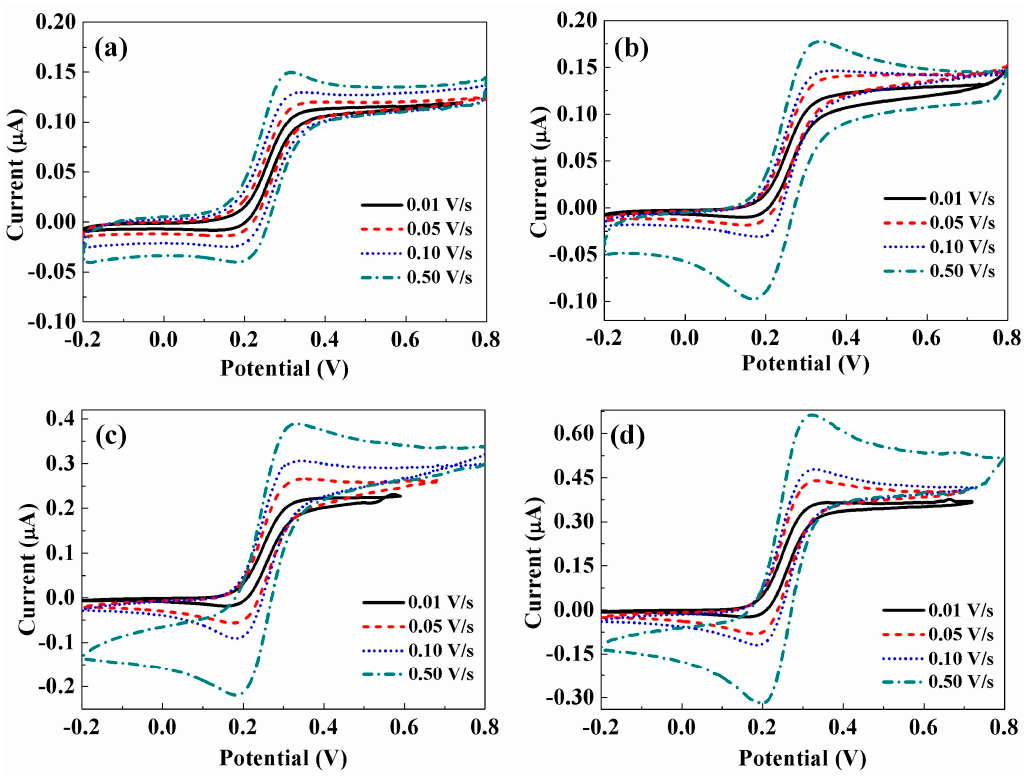
Figure 6. Cyclic voltammograms of ( a ) CFME-T0, ( b ) CNTs/CFME-T5, ( c ) CNTs/CFME-T10, ( d ) CNTs/CFME-T15 in 5.0 mM K 4 Fe(CN) 6 (in 1.0 M KCl) at a scan rate of 0.01 V·s − 1 , 0.05 V·s − 1 , 0.10 V·s − 1 and 0.50 V·s − 1 , respectively.